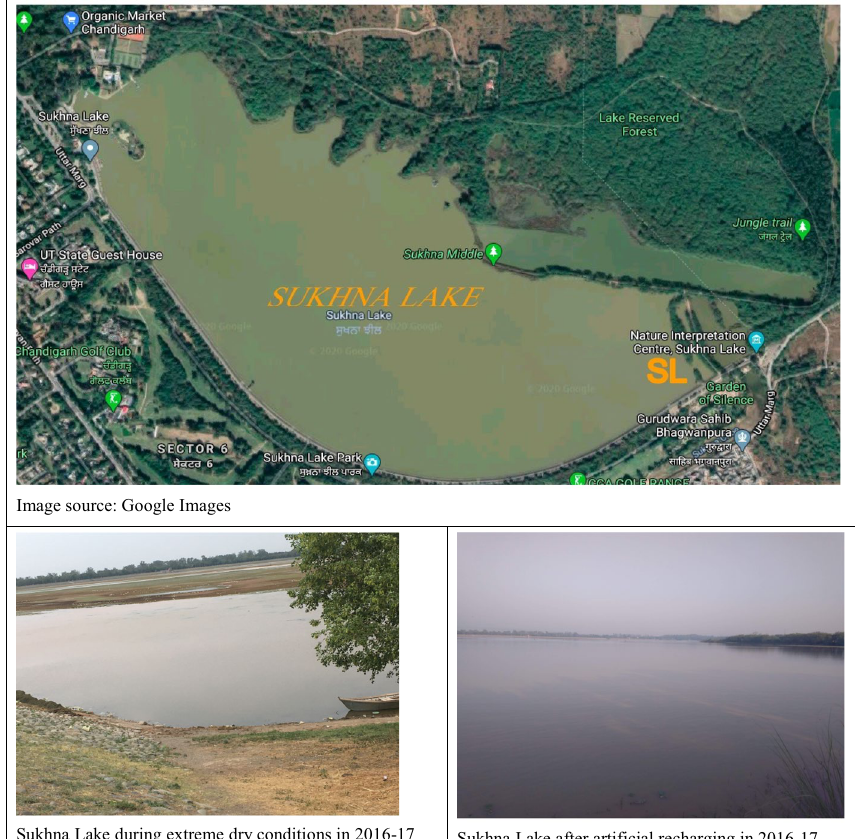
Fig. 1 Study area with site location